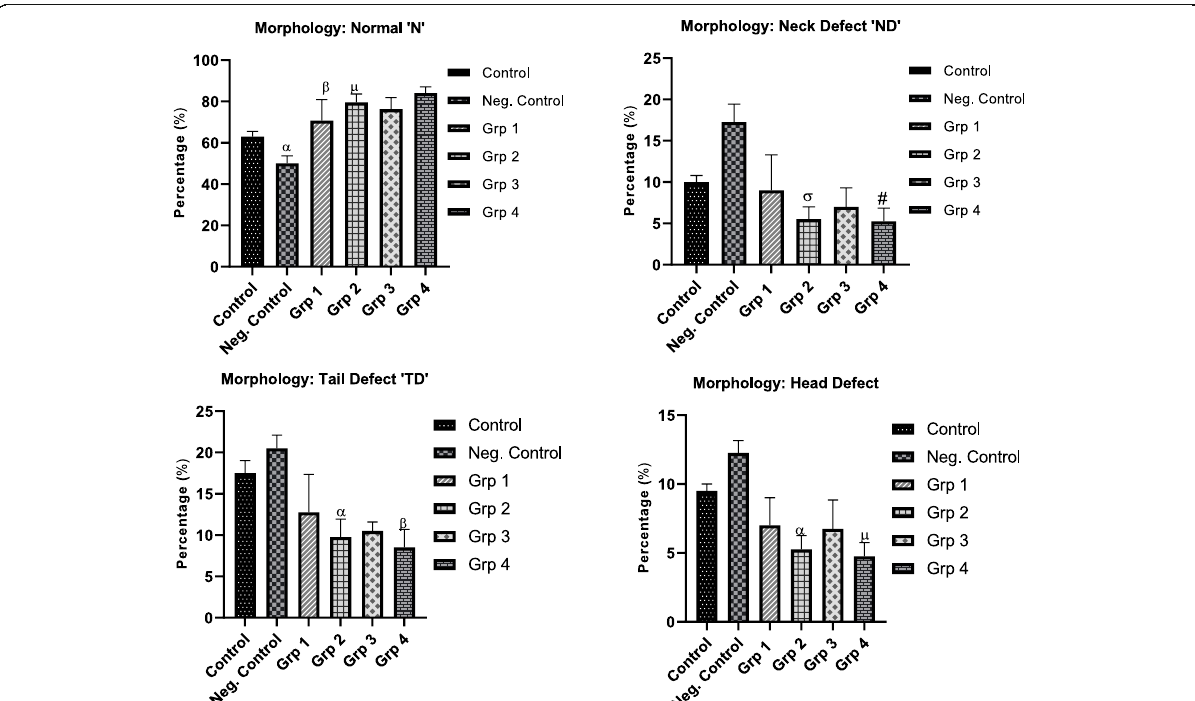
Fig. 3 Graphical representation of sperm morphology; Groups 2, 3 and 4 were statistically significant to Negative control group in the Normal Morphology while groups 2 and 4 were statistically significant to Negative control group in Neck defect, Tail defect and Head defect